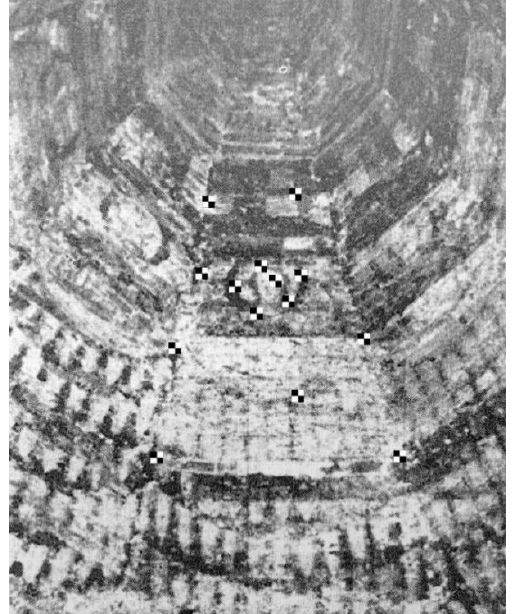
Figure 7. Tie points on wide viewing angle archival image.